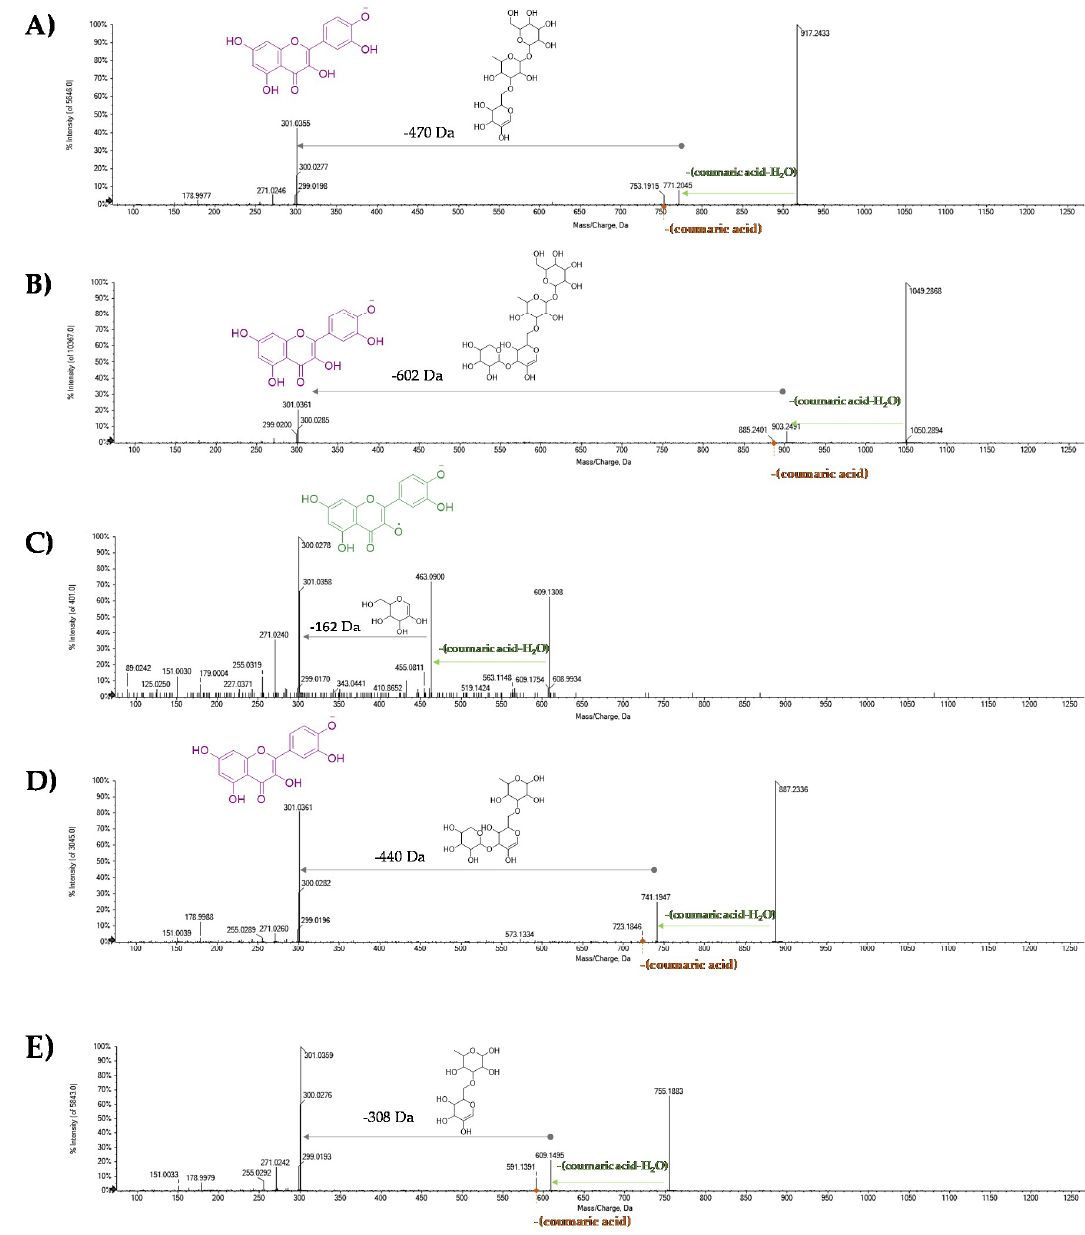
Figure 5. TOF-MS / MS spectra of [M − H] − ion of some of tentatively identified quercetin coumaroyl glycosides ( A ) 36 , ( B ) 37 , ( C ) 38 , ( D ) 39 , and ( E ) 40 . Kaempferol coumaroyl glycosides, such as camellikaempferoside B, were reported as a